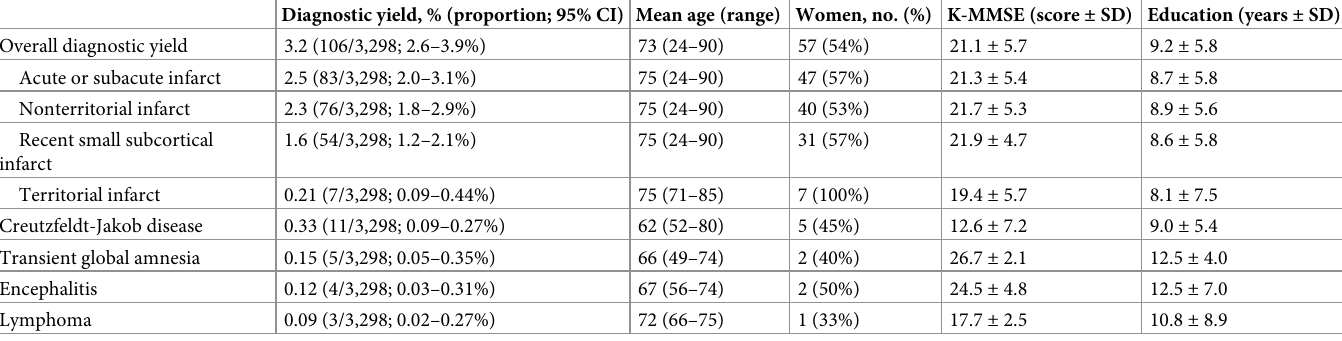
Acute or subacute infarct. All recent small subcortical infarcts were not associated with signal changes on the T2-weighted image, FLAIR image or T1-weighted image except in one case in which the signal change associated with diffusion restricted lesion was indistinguish- able with nonspecific white matter hyperintensities. There were 63 recent small subcortical Table 1. Diagnostic yield of diffusion-weighted imaging in patients with cognitive impairment and clinical characteristics of patients with positive